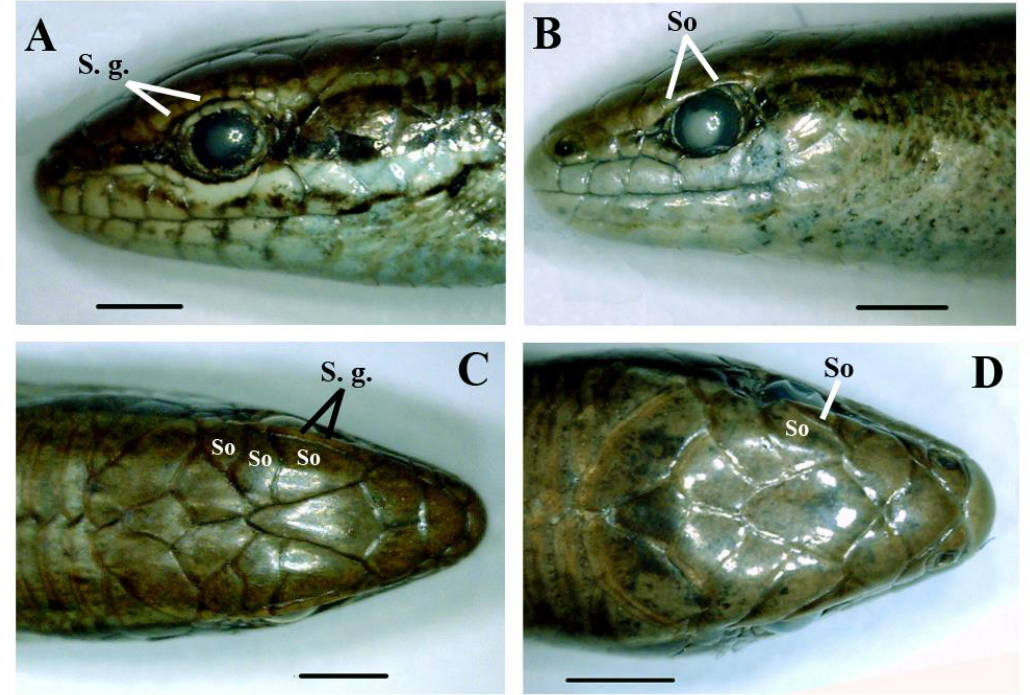
Fig. 6. Lateral (A) and dorsal (C) views of the head scalation of Ablepharus bivittatus (Ménétriés, 1832), (RUZM SA10.5, from near Tabriz, East Azerbaijan Province, NW Iran), and lateral (B) and dorsal (D) views of the head scalation of A. chernovi Darevsky, 1953, (RUZM SA30.2, from